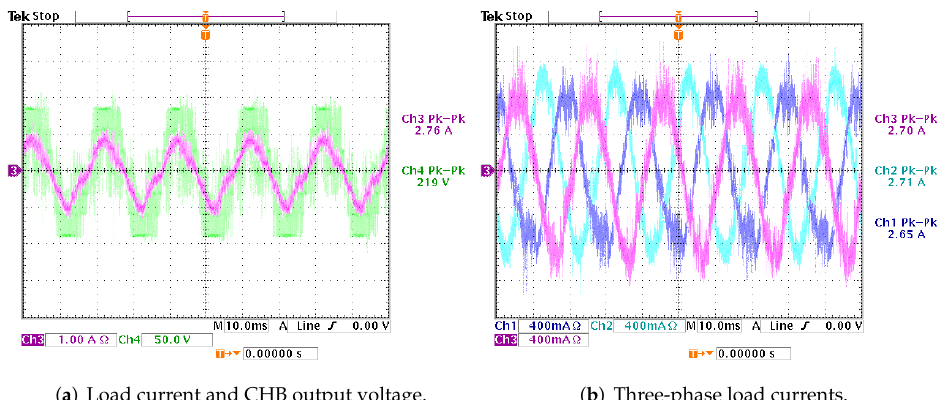
Figure 7. Load currents and CHB output voltage in steady-state